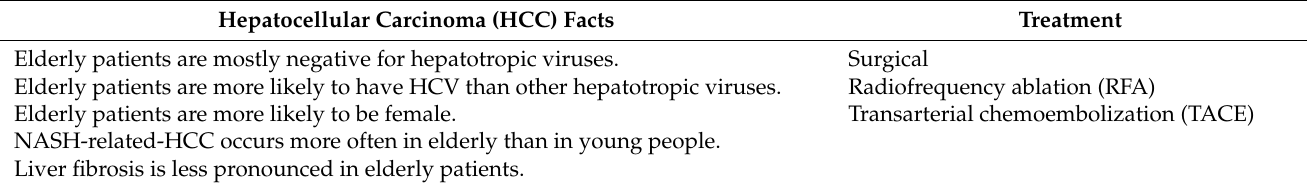
Table 2. Hepatocellular carcinoma in elderly patients. Hepatocellular Carcinoma (HCC) Facts Treatment Elderly patients are mostly negative for hepatotropic viruses.